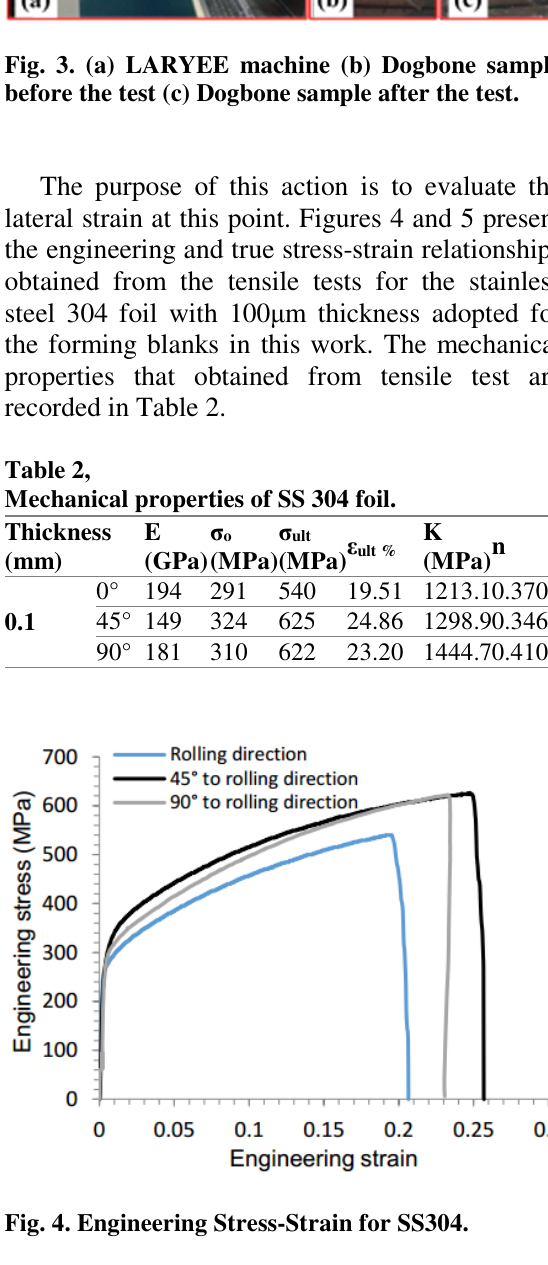
Fig. 5. True Stress-Strain for